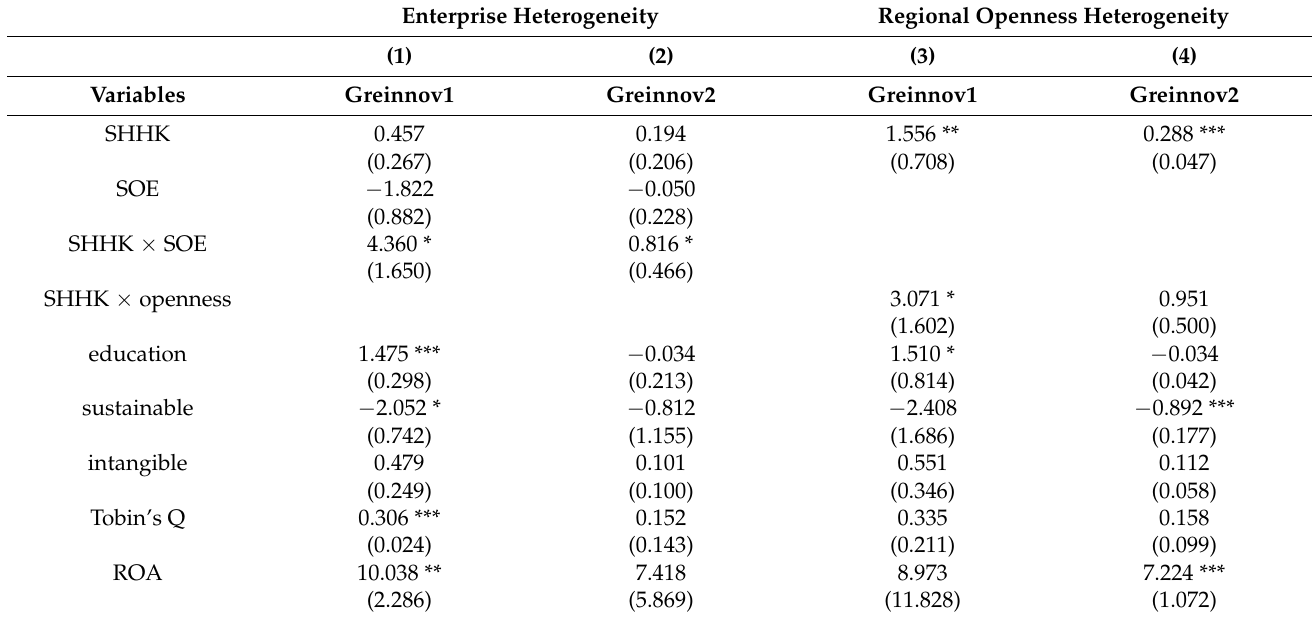
Table 8. Regression results of enterprise heterogeneity and regional openness